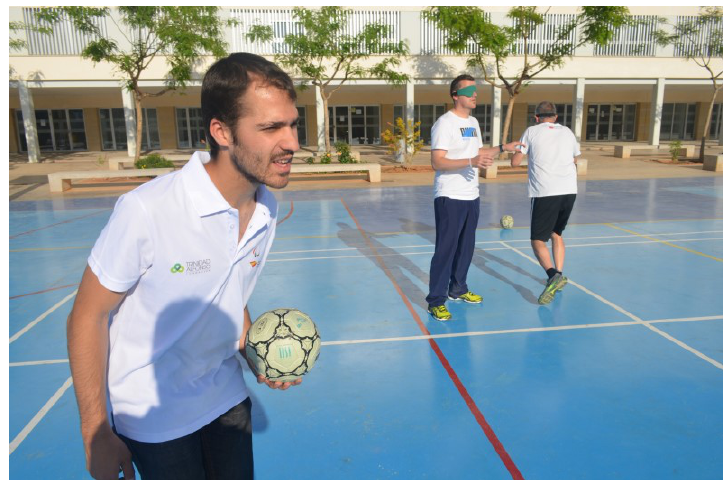
Figure 5. Javier in a teaching action with physical education